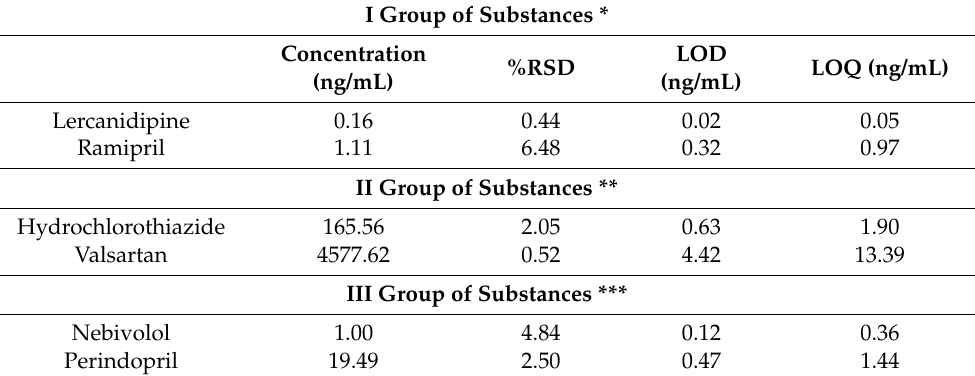
Table 2. The figures of merits of the precipitation procedure, calculated on the basis of the average (n = 5). Results obtained for three patients with resistant hypertension (each patient took a differ- ent group of drugs). %RSD—relative standard deviation; LOD—limit of detection, LOQ—limit of